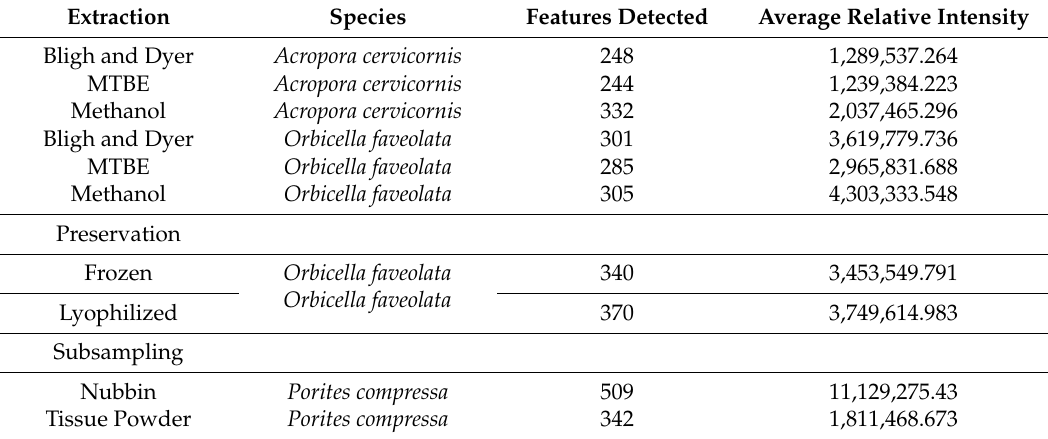
Table 1. Number of features and average spectral intensities for the compared sample preparation methods calculated using an intelligent binning procedure on the raw spectra with a signal-to-noise threshold of 3:1 (NMR ProcFlow v1.2, [56]). MTBE = methyl tert -butyl